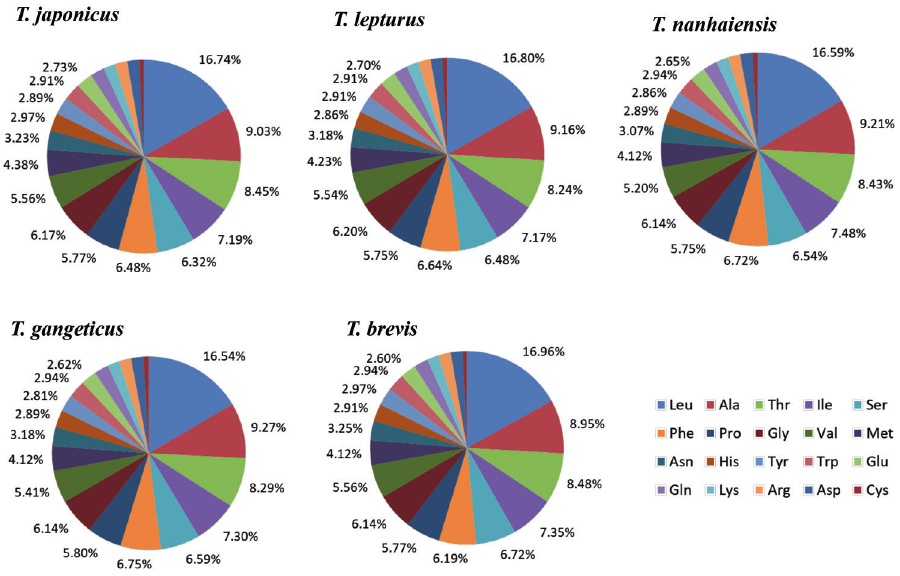
Figure 9. Frequencies of different amino acids in the mitogenomes of the five Trichiurus species; the stop codon is not